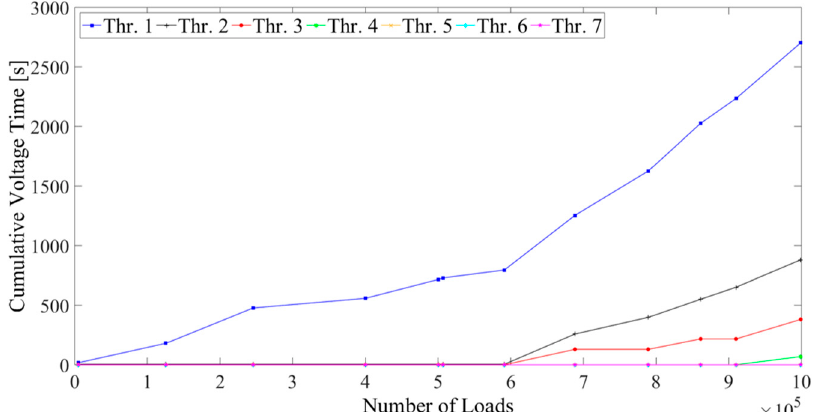
Figure 12. Cumulative voltage time for H4.